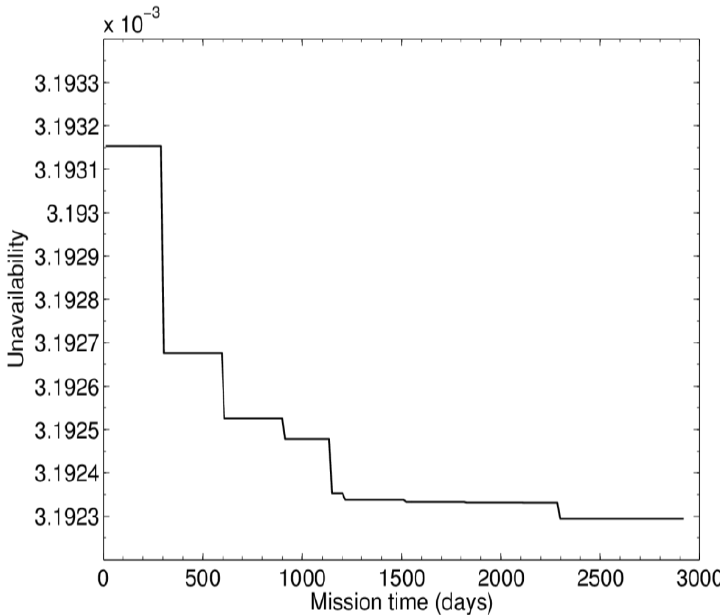
Figure 3. Unavailability evolution of system Version 1 with TP = TP mid (all components).